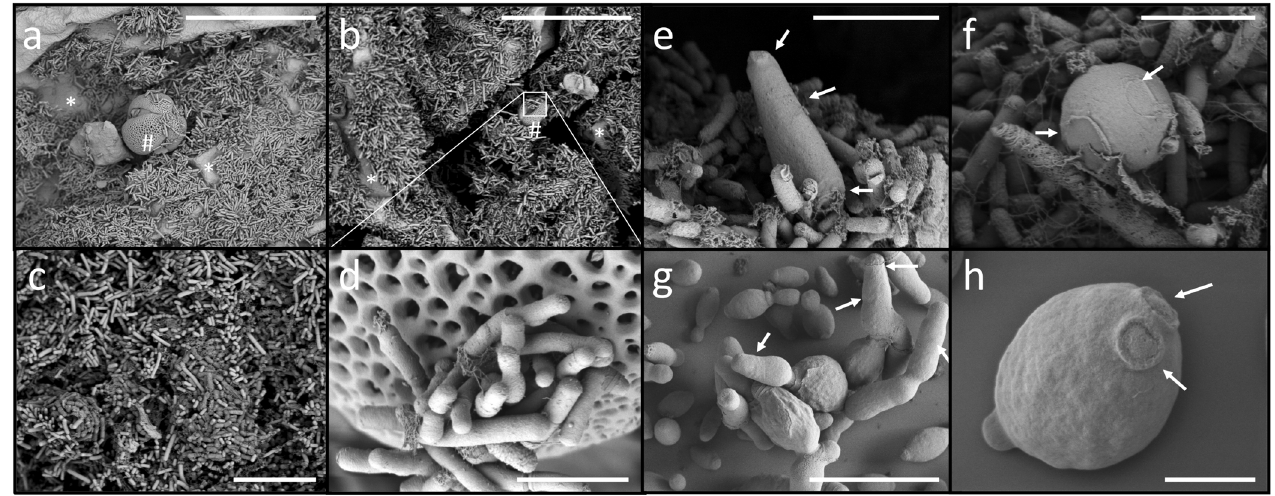
Fig. 1 Visualization of microorganisms inhabiting honeybee guts. a – d Scanning electron microscope (SEM) micrographs showing bacterial cells present in a honeybee gut (i.e., rod-shape bacteria). Grains of pollen covered by bacteria are shown (see also Supplementary Fig. S1). e , f Fungal cells (i.e., yeast) associated with the gut wall of a honeybee. g , h Culture of yeast cells isolated from the honeybee gut. Cells belong to Hanseniaspora uvarum (strain L18) and Starmerella bombicola (strain L28; see also Supplementary Fig. S9 and Supplementary Table S7). Note the different scales on the SEM photographs. Honeybees used for SEM analysis were A. mellifera jemenitica from Saudi Arabia (Supplementary Table S6). Scale bars correspond to ( a , b ) 30 µm, ( c ) 3 µm, ( d , f ) 2 µm, ( e , g ) 10 µm, and ( h ) 1